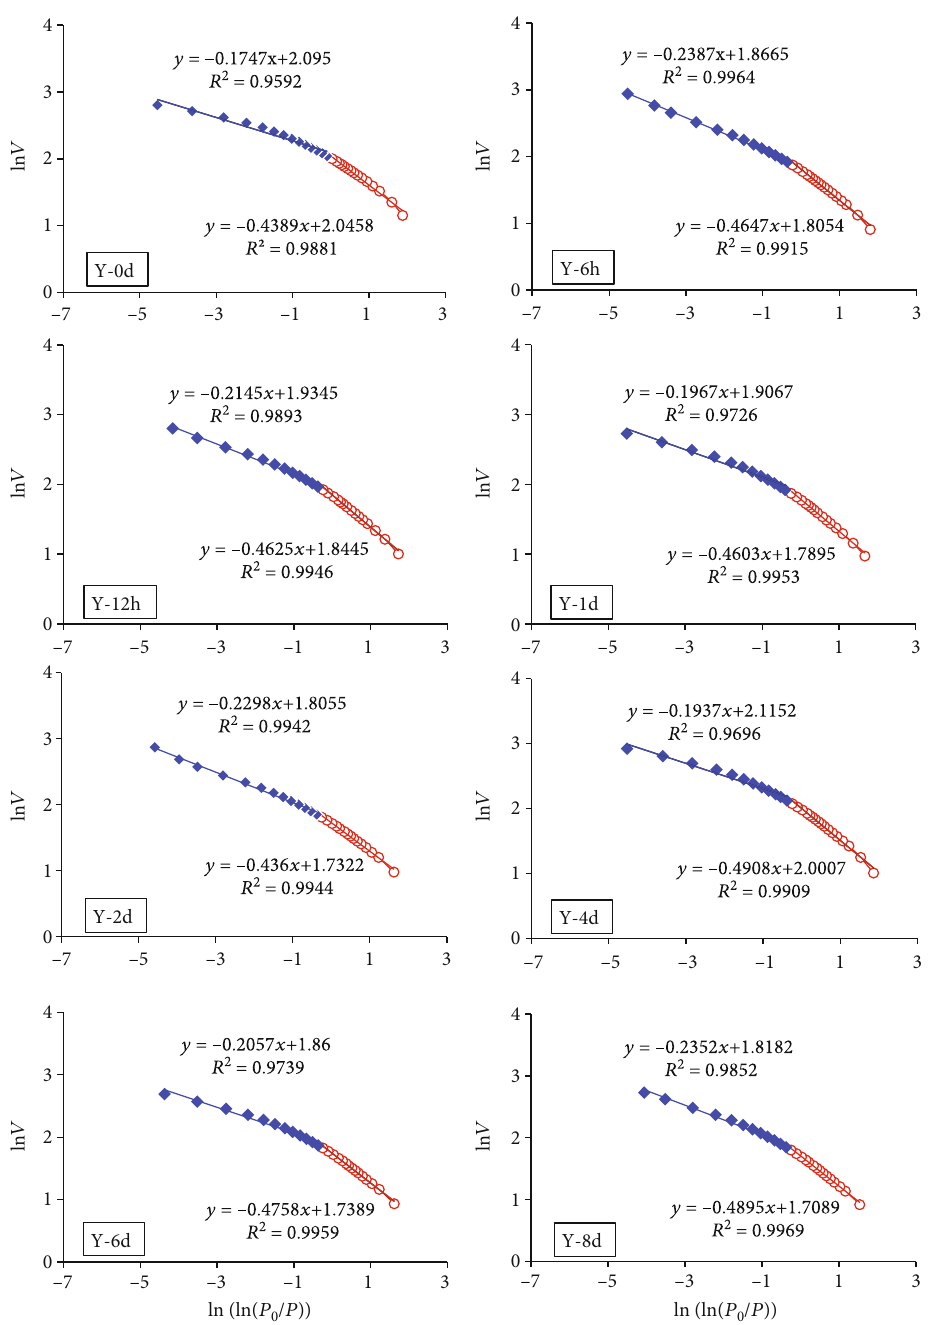
Figure 6: ln V vs. ln ð ln ð P